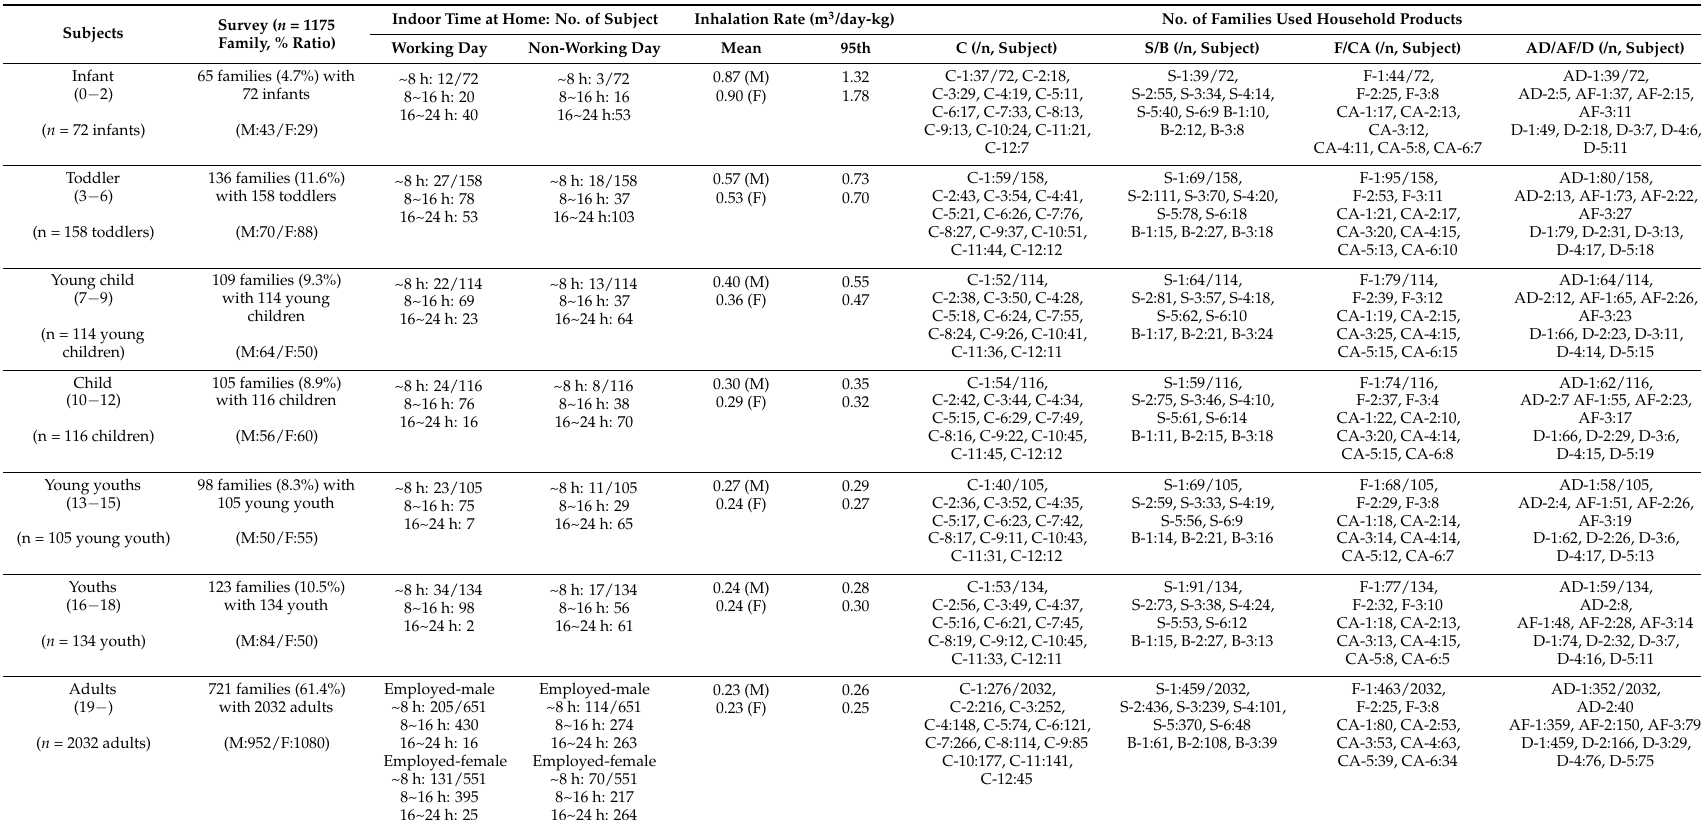
Table 7. Indoor times and products used by the surveyed